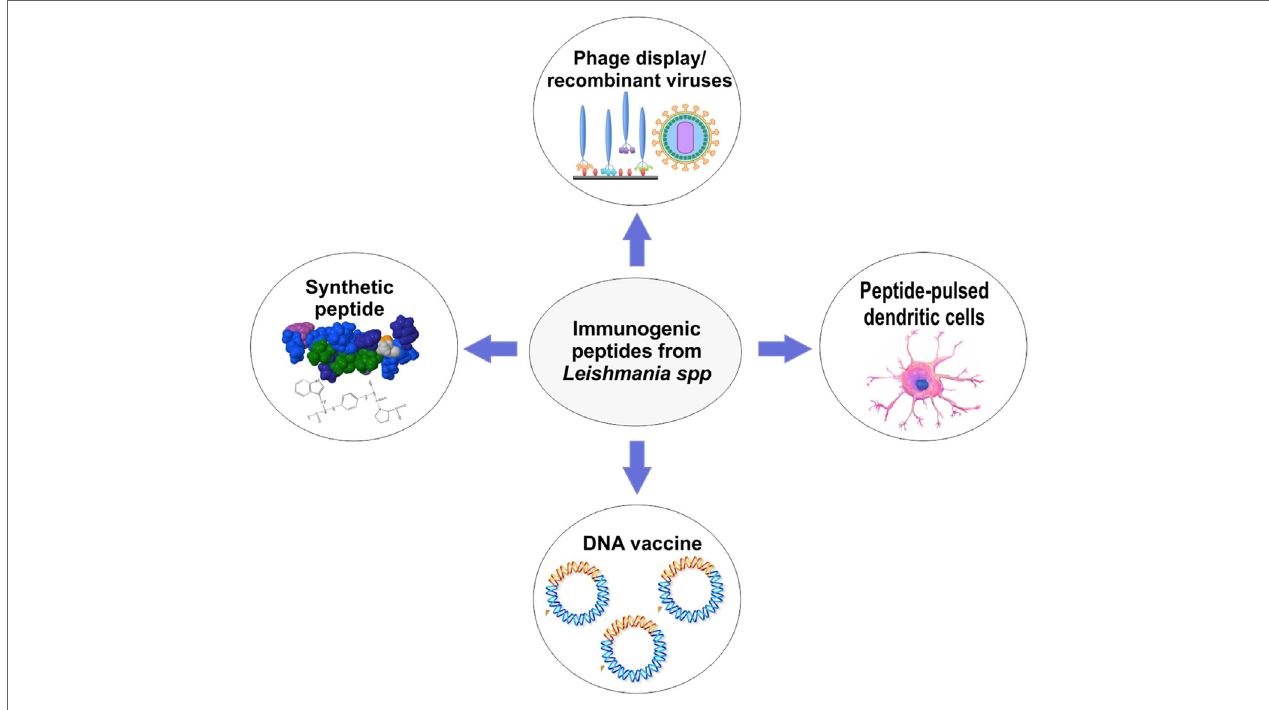
FigURe 2 | Overview of approaches that can be used for peptide-based vaccines development against cutaneous and visceral